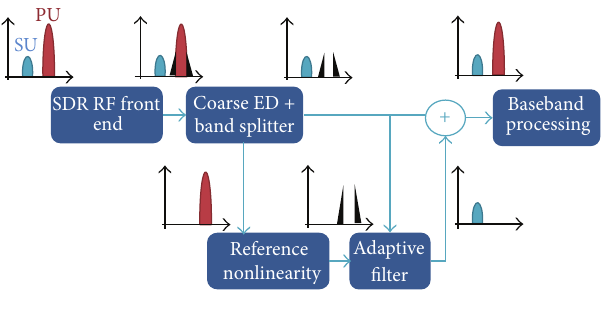
Figure 12: The AIC